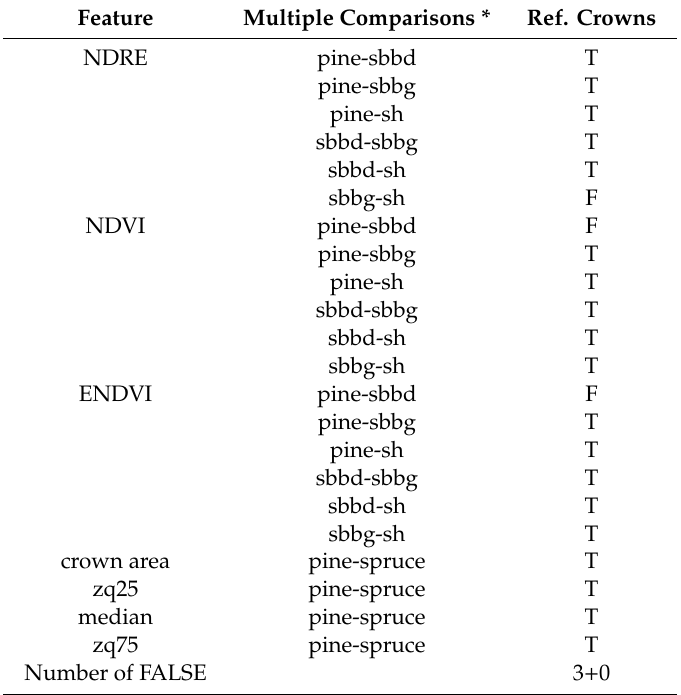
Table 10. The multiple comparisons test between information (disturbance) classes within the